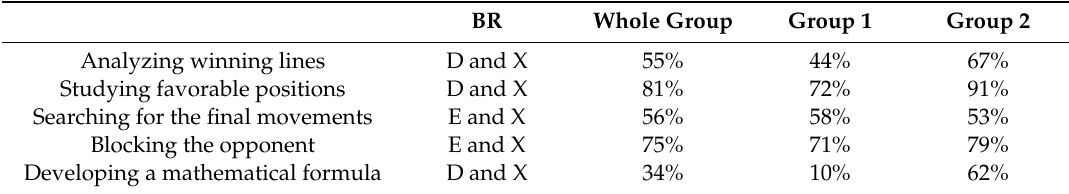
Table 1. Backward reasoning and academic level groups. BR: backward reasoning; D: breakdown; X: auxiliary elements; E: cause–e ff ect relationship.